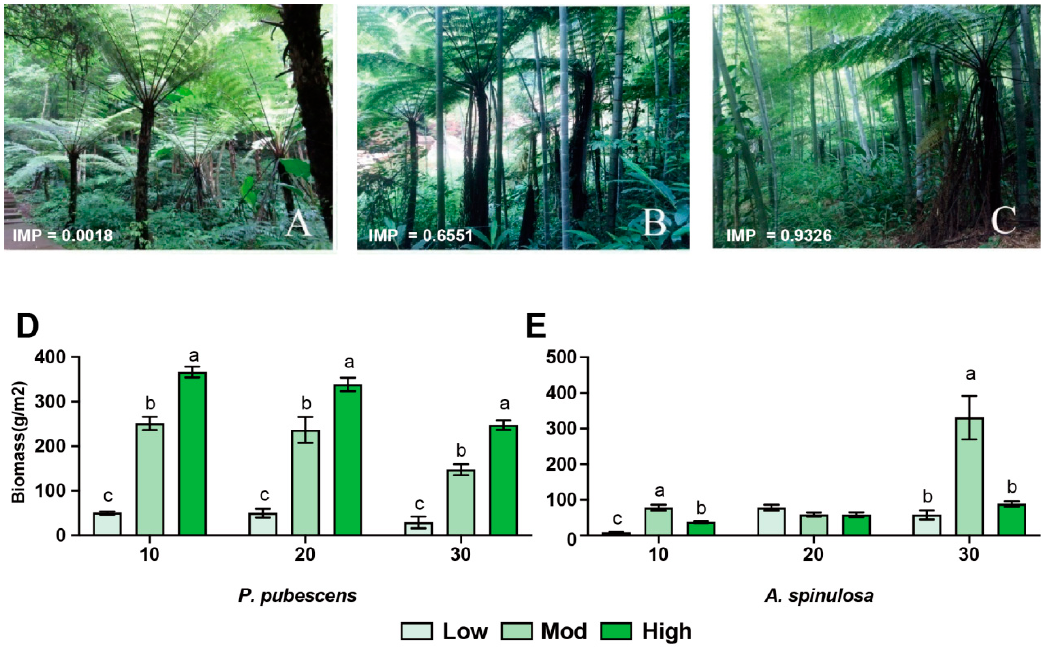
Figure 1. Effects of moso bamboo invasion on forest structure and tree characteristics. ( A – C ) Field pictures of A. spinulosa community disturbed by low ( A ), moderate ( B ), and high ( C ) moso bamboo invasions. IMP indicates the importance value of moso bamboo. ( D , E ) Root biomass of moso bamboo ( D ) and A. spinulosa ( E ) at different vertical depths, respectively. abc Different superscripts indicate the significant difference ( p < 0.05). Table 1. The basic information about three sampling sites.